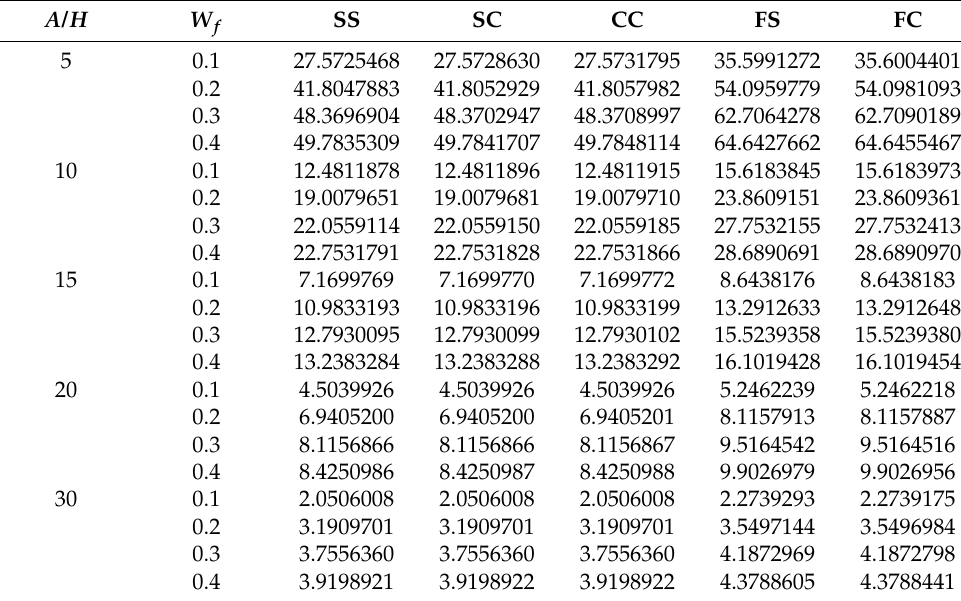
Table 6. Dimensionless transverse shear stress σ ∗ of FG porous nanocomposite piezoelectric square 13 plates under various boundary conditions and for different values of side-to-thickness ratio A / H and GPLs weight fraction W f ( x 3 / H = 0).